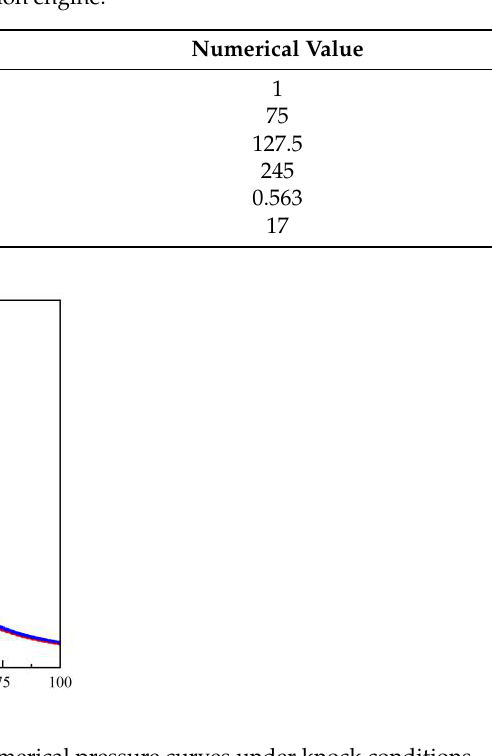
Figure 4. Comparison of experimental and numerical pressure curves under knock conditions.